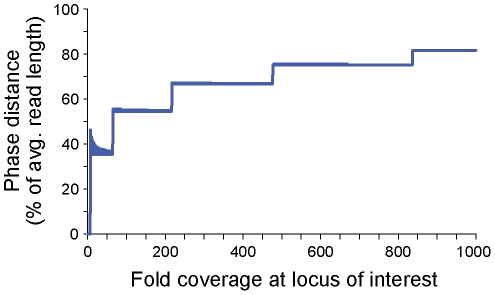
Phase distance approached length of average read as coverage increased.The phase distance was longer than half the average read length for loci covered more than 65-fold, and as coverage increased, it approached the length of the average read. The phase distance is a measure of how far apart phased variants can be and still be detected at lower frequencies than variants not in phase. We show the phase distance as a percentage of average read length.